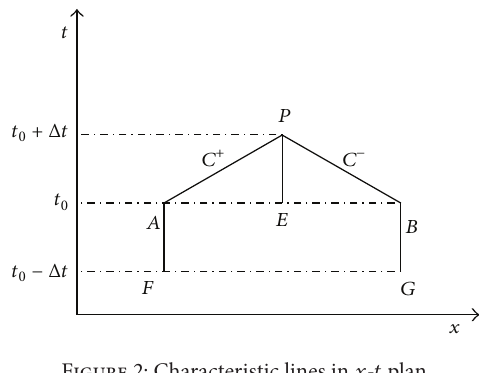
Figure 2: Characteristic lines in 𝑥 - 𝑡